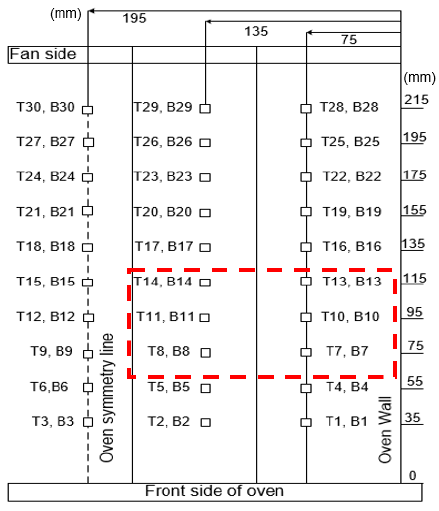
Figure 14. Positioning of FPCB on the steel cage in the desktop reflow